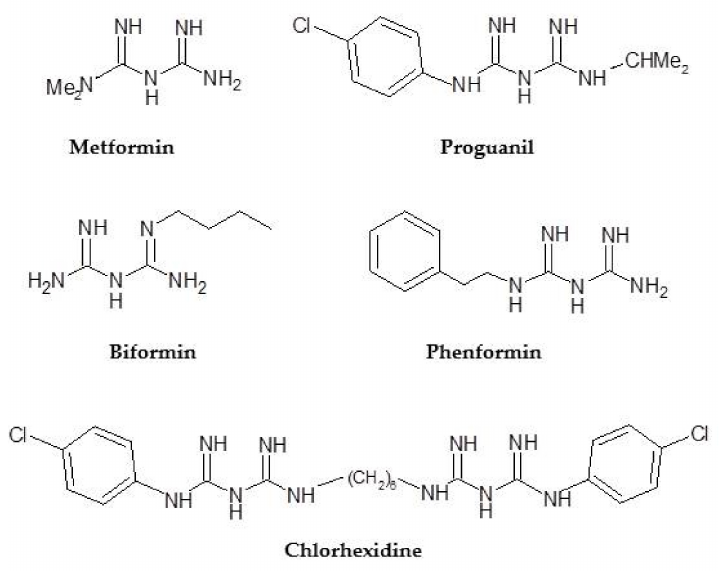
Figure 2. Biguanides with important medical